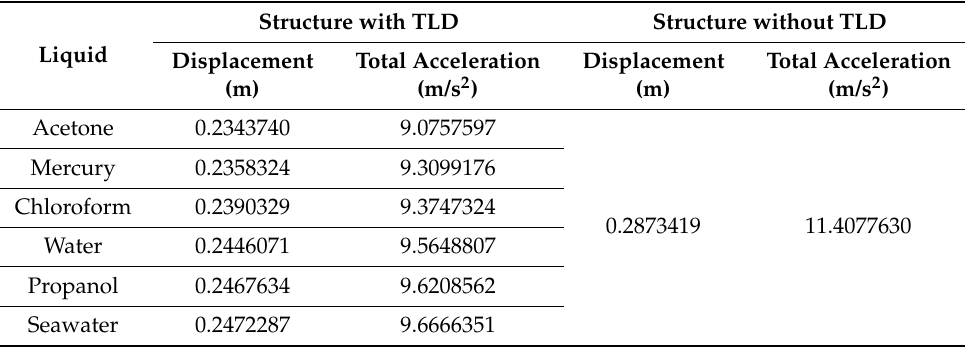
Table 5. TLD + single-story building model critical earthquake analysis results.